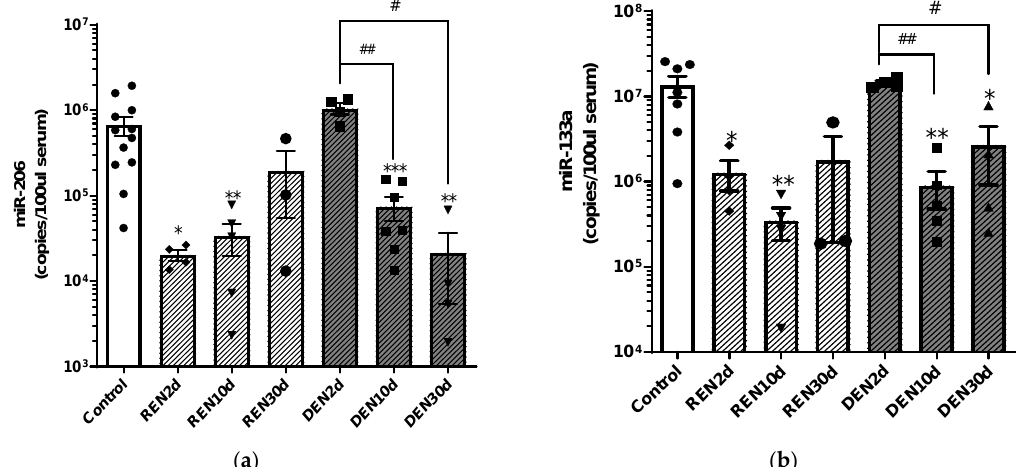
Figure 2. Serum levels of miR-206 and miR-133a during muscle denervation and re-innervation. Absolute quantification of miR-206 ( a ) and miR-133a ( b ) serum levels in re-innervating (REN) and denervated (DEN) gastrocnemius muscles, 2 days (2 d), 10 days (10 d) and 30 days (30 d) after sciatic nerve resection (* comparison vs. control: * p < 0.05, ** p < 0.005, *** p < 0.0005. # comparison between groups: # p < 0.05, ## p < 0.005. •, ▲ , ▼ , , ■, represent samples in control, re- innervating and denervated groups). ◆ 3.2. MiR-206 is Differently Modulated in Fast and Slow Progressive SOD1 G93A Mice ALS patients display signs of denervation and re-innervation of muscle fibers during disease progression. To evaluate the levels of circulating myomiRs during ALS’ patholog- ical alteration of muscle–nerve communication, we performed an absolute RT-PCR quan- tification of miR-206 and miR-133a in the serum samples of ALS mouse models at different stages of the disease. We analyzed the copy numbers of circulating miR-206 at the onset (90 days) and at the end stage (150 days) of the disease in fast progressing SOD1 G93A high-copy mice (Fig- ure 3). As shown in Figure 3, we did not observe any difference in miR-206 levels between wild type and SOD1 G93A high-copy mice at the onset of the disease, while we observed higher levels of miR-206 at the terminal phase of the disease, compared to both wild type and to SOD1 G93A high-copy mice at the onset stage. Further, to better evaluate whether the velocity of disease progression could be re- lated to the level of miR-206, we took advantage of another transgenic ALS mouse model, namely the SOD1 G93A low-copy model, which exhibits a slow progression of the disease. We analyzed the levels of circulating miR-206 at the onset (150 days), at the late (220 days) and at the end stage (250 days) of the pathology (Figure 3); we observed that circulating levels of miR-206 were significantly upregulated at the late symptomatic phase (220 days) compared to wild type control mice and to early symptomatic (150 days) and end stage